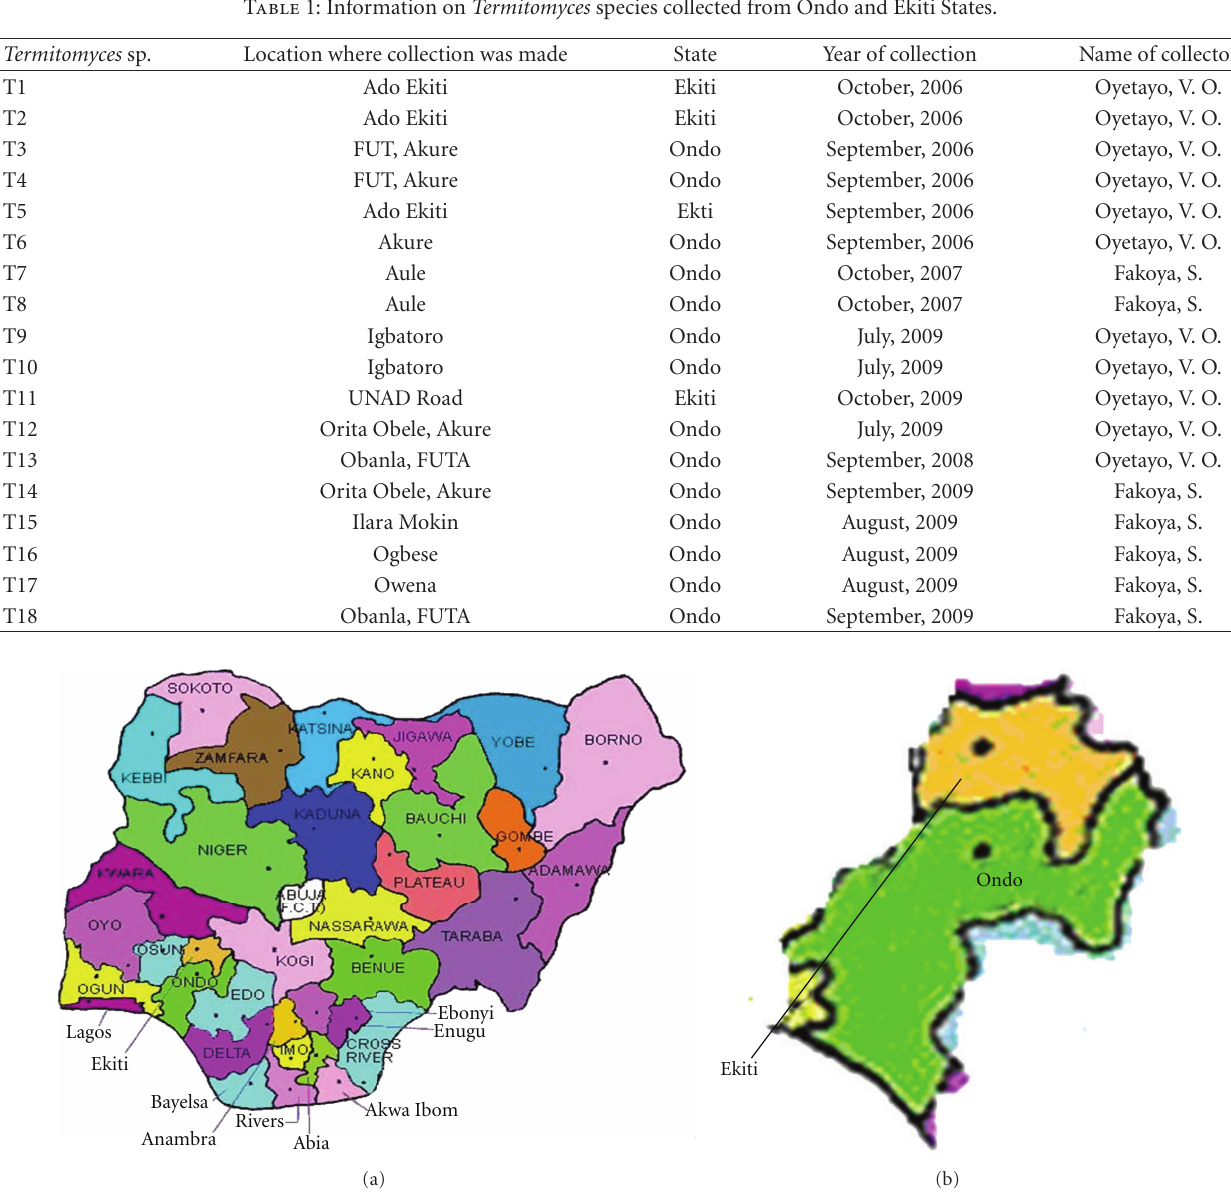
materials were transferred into well-labeled tube. Prewarmed extraction bu ff er (CTAB) was added, and the tubes were incubated at 65 ◦ C for 30 to 60 minutes. Equal volume